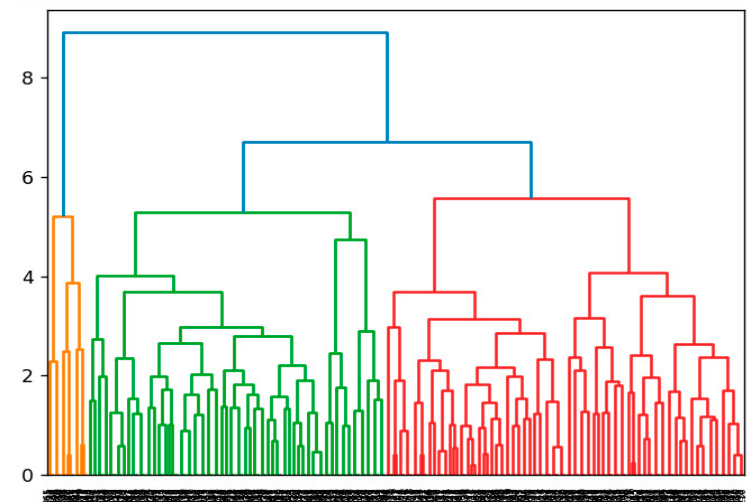
Figure 4. Hierarchical cluster analysis (dendrogram).